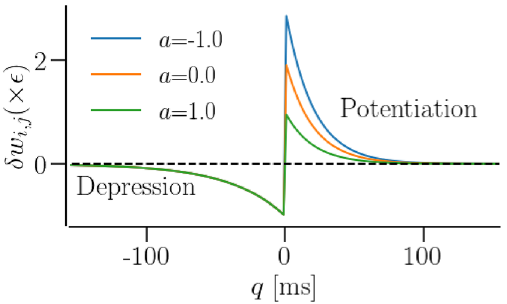
Figure 1. Spike-timing-dependent plasticity. Synaptic weight increment vs. spike timing difference (time lag) according to Eq. (2) for different values of the asymmetry parameter, a . When a postsynaptic neuron fires before or at the same time as its presynaptic partner, i.e., when q ≤ 0 , the synaptic weight decreases (depression), while it increases when q > 0 (potentiation). A positive asymmetry makes the STDP rule potentiation dominant, zero makes it symmetric, and negative makes it depression